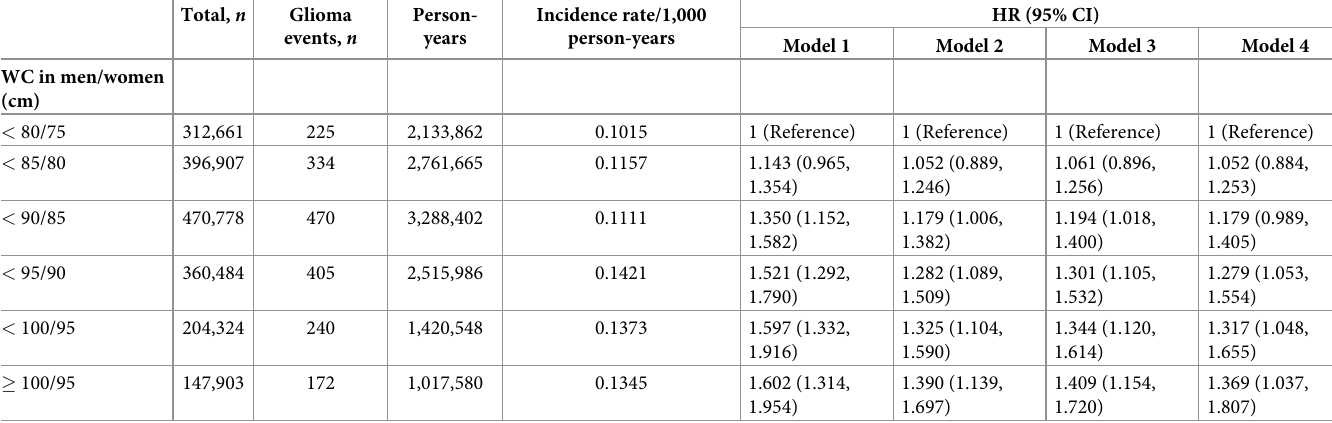
Table 2. Incidence rates and hazard ratios for the development of glioma in diabetic patients according to the waist circumference. WC in men/women (cm) < 80/75 312,661 225 2,133,862 0.1015 1 (Reference) 1 (Reference) 1 (Reference) 1 (Reference) < 85/80 396,907 334 2,761,665 0.1157 1.143 (0.965,